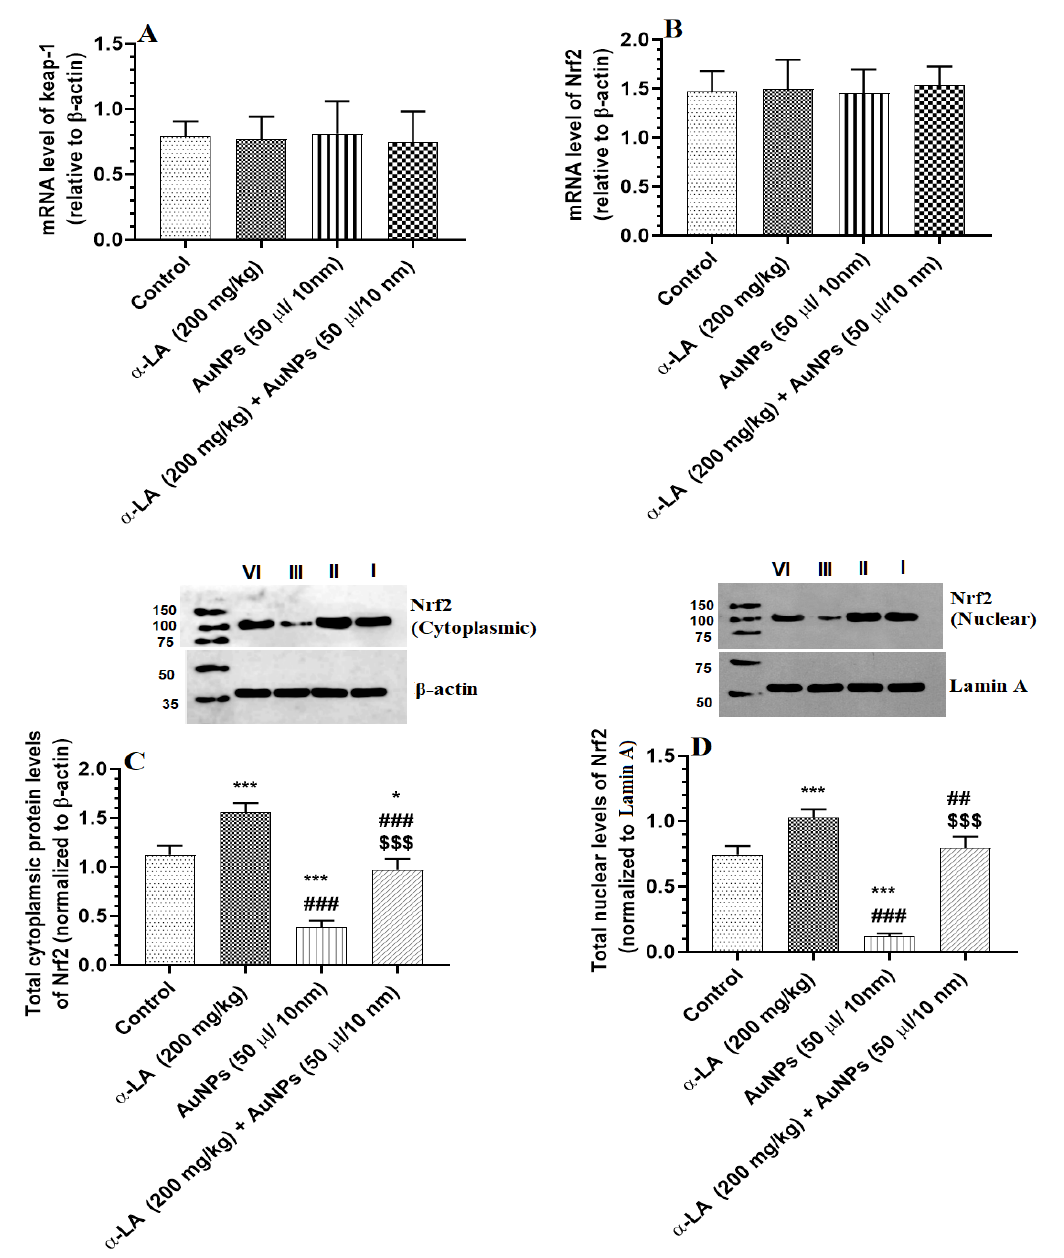
Figure 5. α -lipoic acid ( α -LA) increases the total and nuclear protein levels of nuclear factor erythroid- derived 2-like 2 (Nrf2) without altering the mRNA levels of Nrf2 and Kelch-like ECH-associated pro- tein 1 (keap-1) in the livers of the control and gold nanoparticles (AUNPs)-treated rats. ( A , B ): mRNA levels of keap-1 and Nrf2, respectively, as detected by real-time PCR. ( C , D ): blots and figures rep- resenting the total and nuclear levels of Nrf2 as depicted by western blotting. Data were given as means SD (n = 8/group) for mRNA levels. p < 0.05. *, ***: vs. control (lane I) at p < 0.01, and 0.0001, ± respectively; ##, ###: vs. α -LA (lane II) at p < 0.01 and 0.0001, respectively; and $$$: vs. AuNPs (lane III) at p < 0.0001. lane IV: AuNPs + α